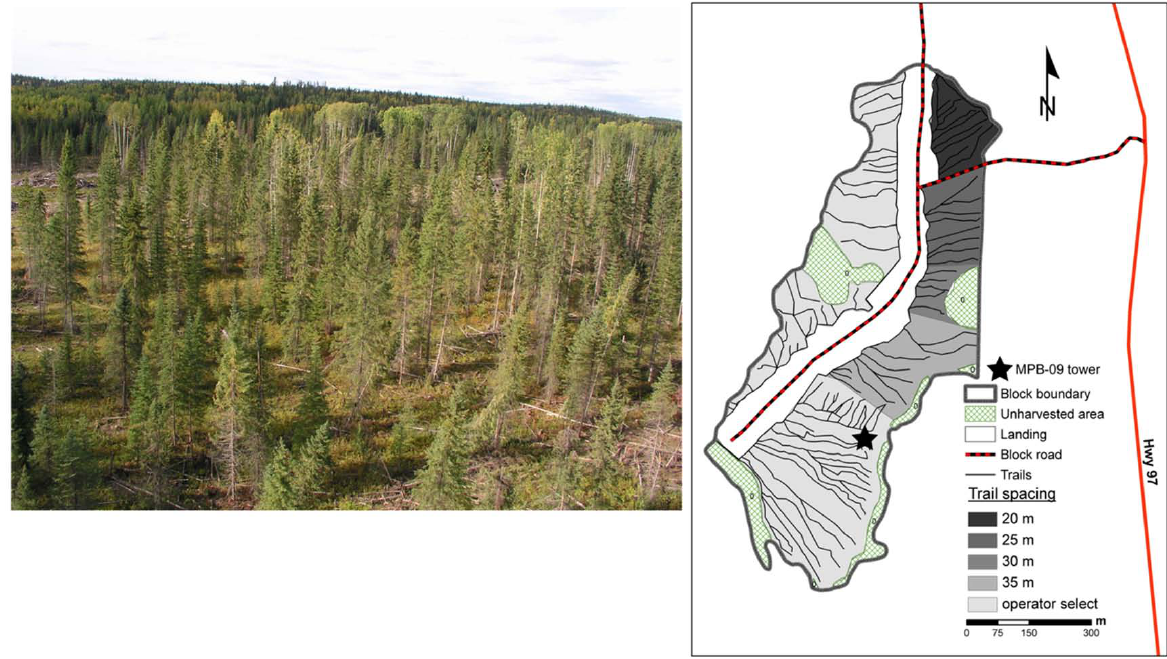
Fig. 1. Photograph and schematic diagram of the partially harvested stand with locations of the MPB-09 flux tower and harvesting trails. The clear-cut, MPB-09C, is located 1km north of MPB-09. Source: Nishio